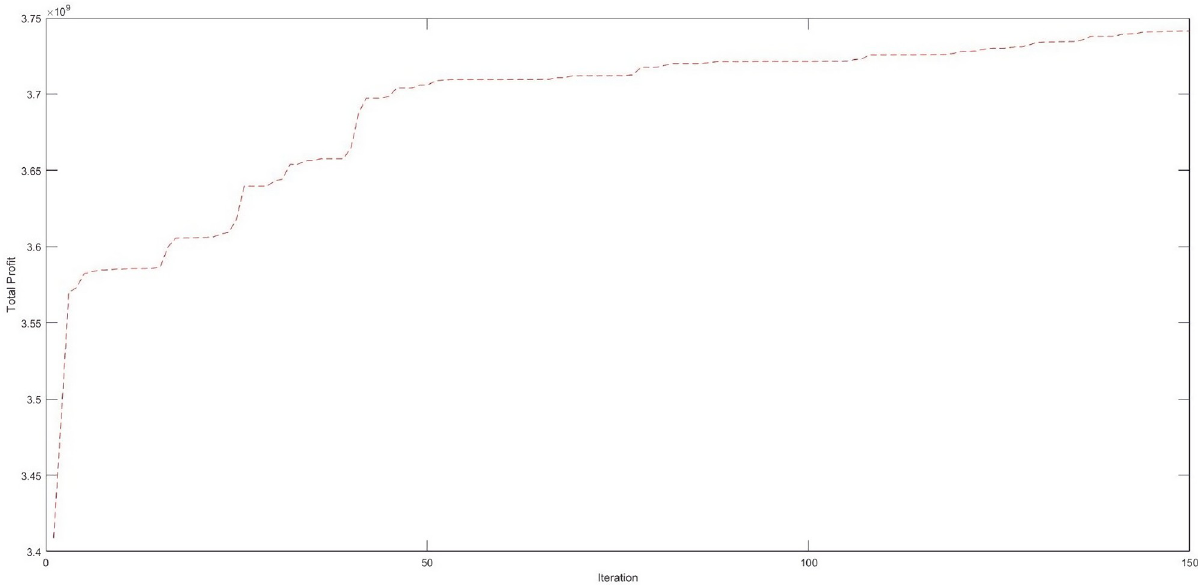
Fig 14. The convergence of the VDO algorithm in reaching the maximum profit.